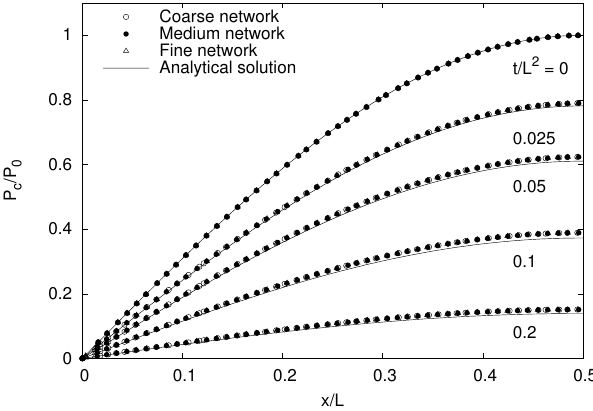
Figure 8. Capillary suction distributions due to non-stationary transport.